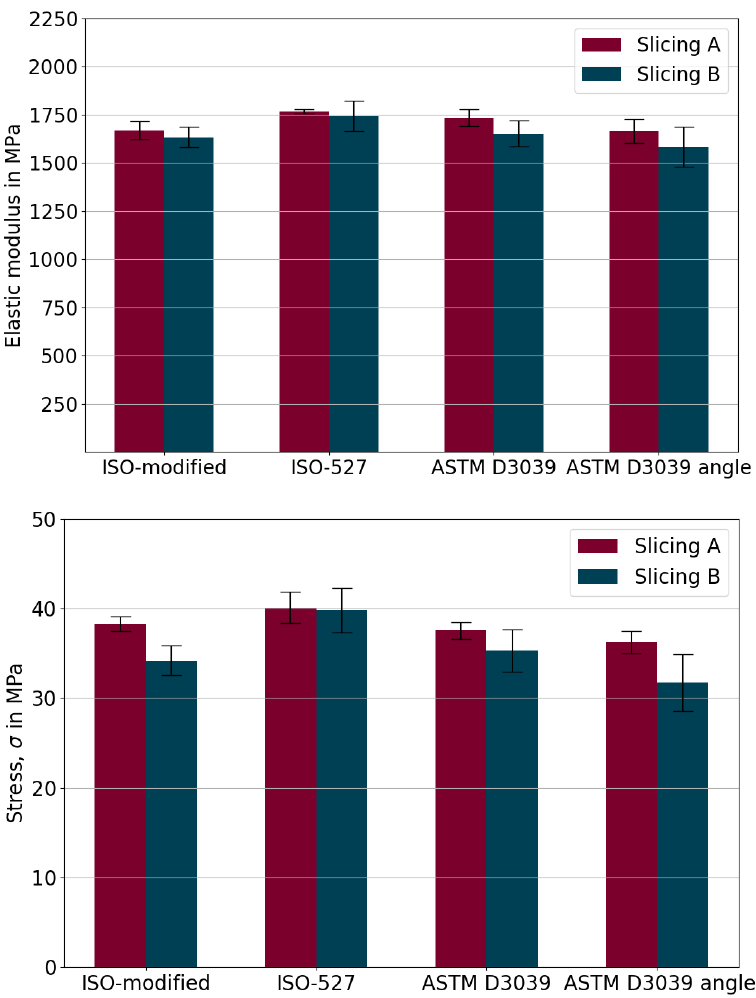
Figure 10. Quantitative comparison of the geometry effect in the case of tensile tests. Arithmetic mean Young’s modulus, E , and maximum stress before